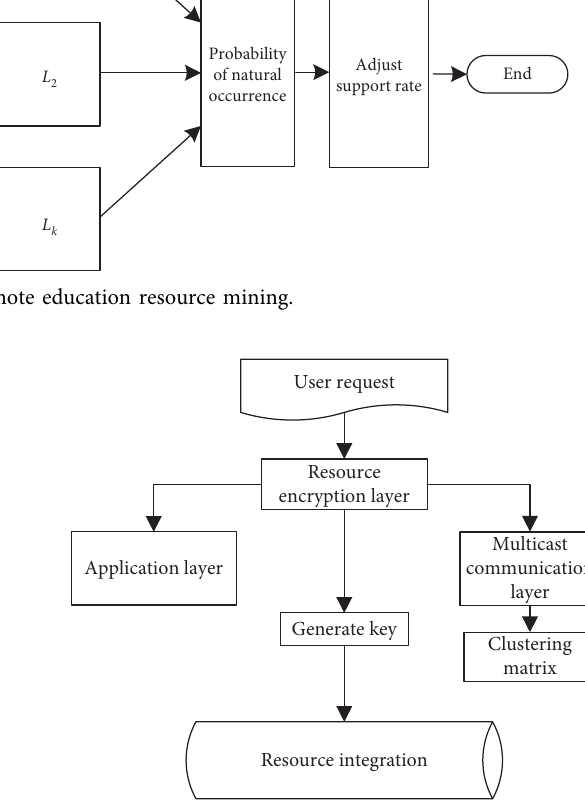
Figure 3: Schematic diagram of remote education resource inte- gration